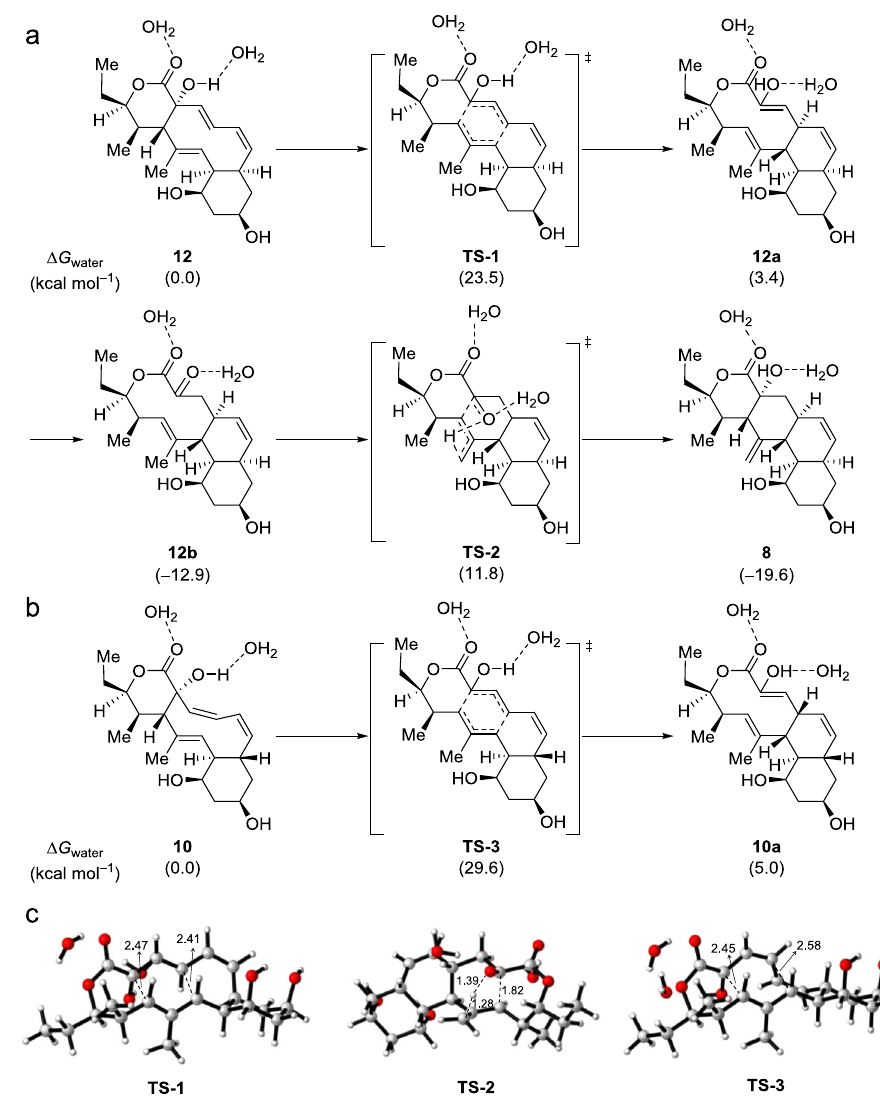
Fig. 4 DFT-computed Gibbs free energies. a the Cope rearrangement of 12 and the subsequent Alder-ene reaction; b the Cope rearrangement of 10 ; c transition-state structures (Carbon: gray, Hydrogen: white, Oxygen: red, and distances are shown in